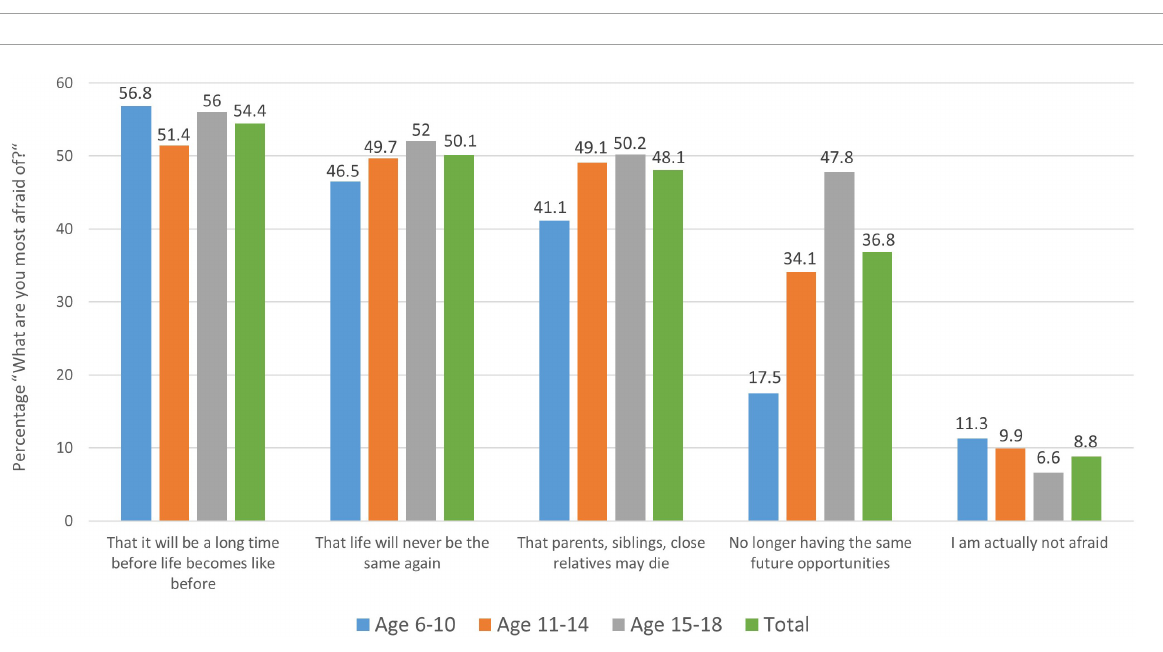
FIGURE2 Distribution of children’s and young people’s answers to the question “What are you most afraid of in relation to the coronavirus?” by age group. Here the mean of each age group as well as the total grand mean are shown next to each other for the most prevalent answer options chosen by the children and adolescents. Note that only about 8.8% of the participants state that they are “actually not afraid” and therefore chose none of the fear-related answer